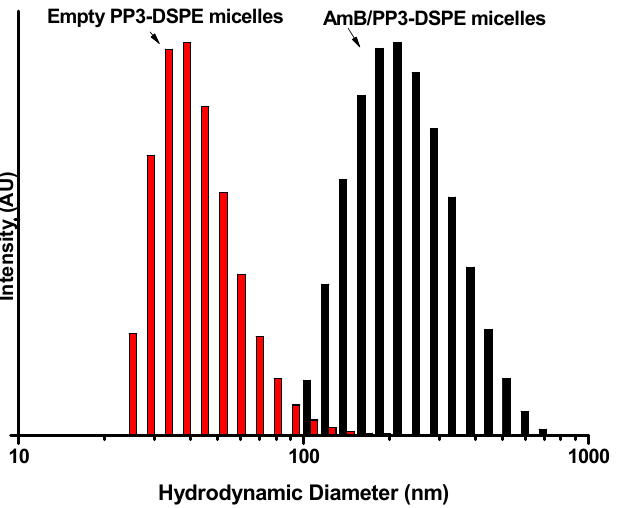
Figure 4. Comparison of the distribution plots of the hydrodynamic diameter of empty micelles and AmB-loaded particles obtained from PP3-DSPE.